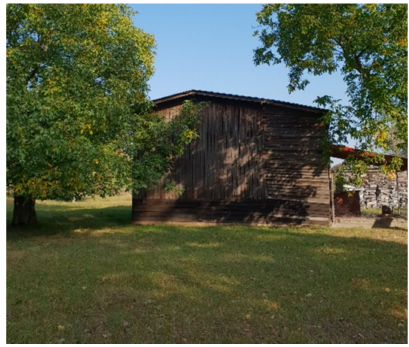
Figure 10. External view of the